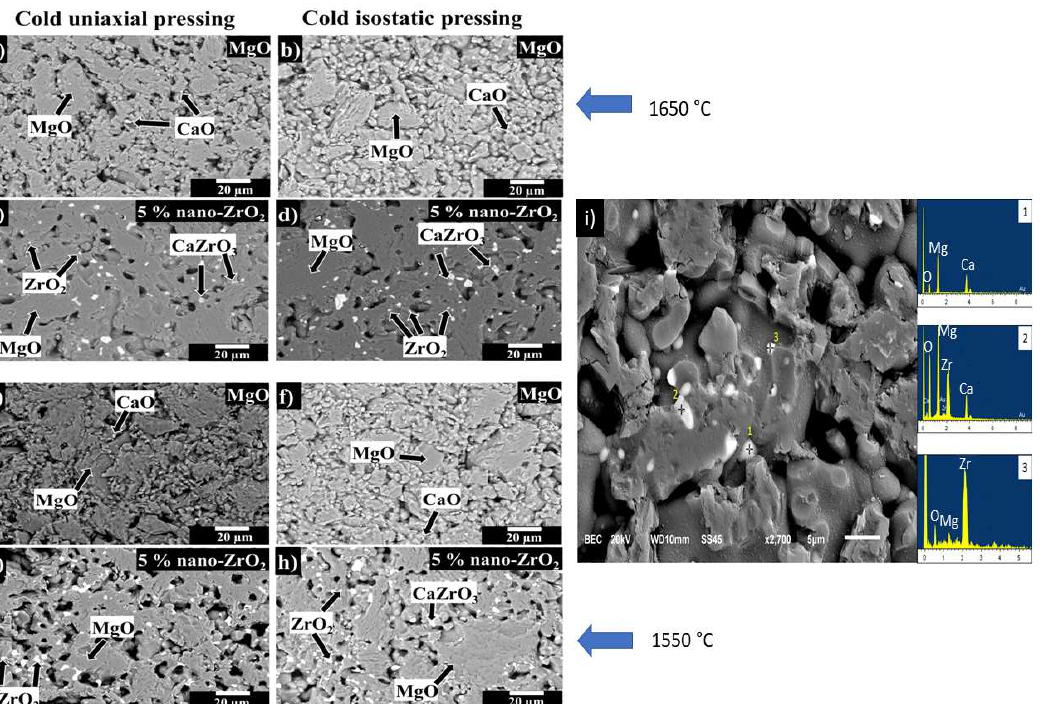
Figure 3. SEM images. ( a , b ) 100 wt.% MgO samples and ( c , d ) specimens MgO containing 5 wt.% of ZrO 2 nanoparticles, all sintered at 1650 °C. ( e , f ) 100 wt.% MgO and ( g , h ) MgO containing 5 wt.% of ZrO 2 nanoparticles, all sintered at 1550 °C. ( i ) shows the shape of each of the phases identified as point 1 (CaO), point 2 (CaZrO 3 ), point 3 (ZrO 2 ). ( a , c , e , g ) correspond to samples pressed by CUP. ( b , d , f , h ) correspond to samples pressed by a CUP + CIP.